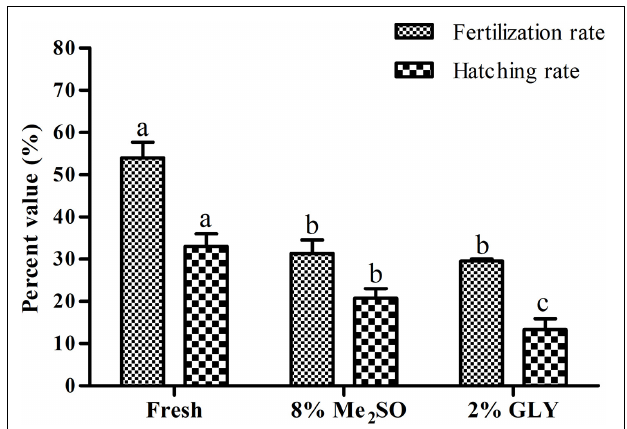
FIGURE 9 | Fertilization and hatching rates of cryopreserved sperm of Pacific abalone ( n = 3). Different superscript letters (a and b) above bars indicate significant ( p < 0.05) differences between different